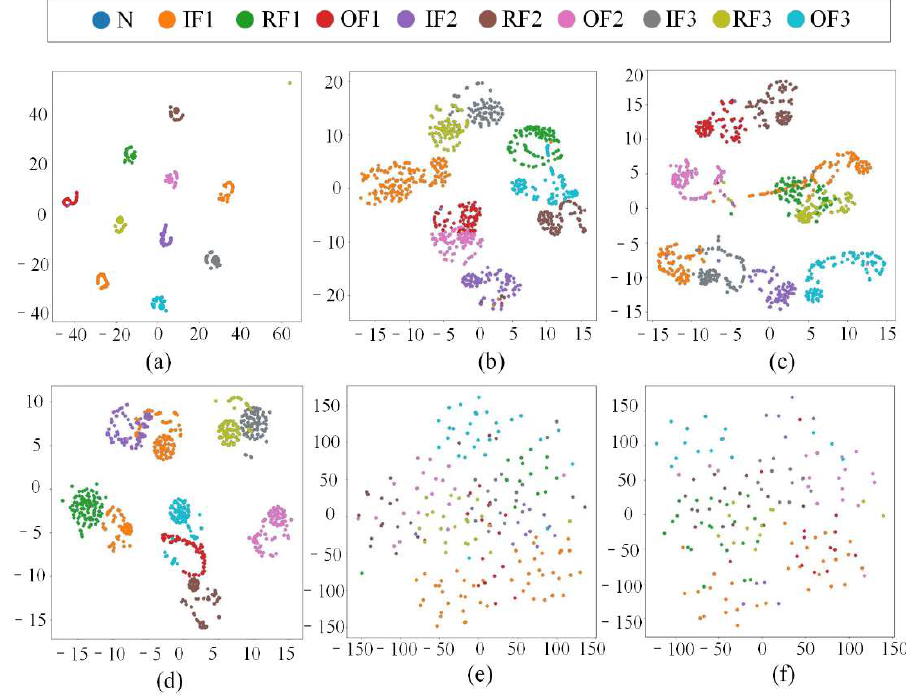
Figure 15. Visualization of different diagnostic results on dataset A, ( a ) The proposed method, ( b ) GAF-SE-CNN, ( c ) GAF-CBAM-CNN, ( d ) GAF-BAM-CNN, ( e ) VMD-Gray image-Resnet50, ( f ) EMD-Gray image-Resnet50.